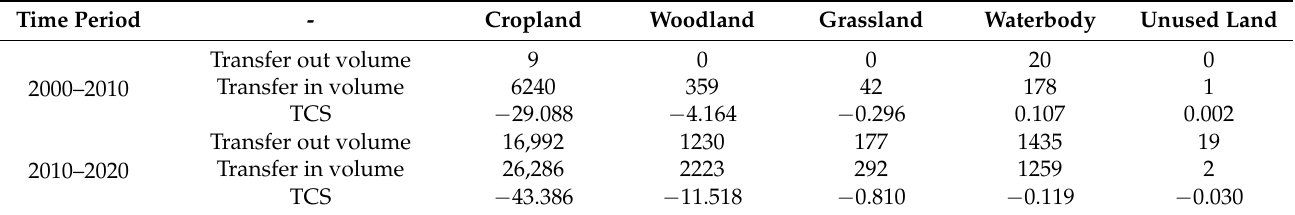
Note: Positive values indicate an increase in TCS and negative values indicate a loss of TCS.